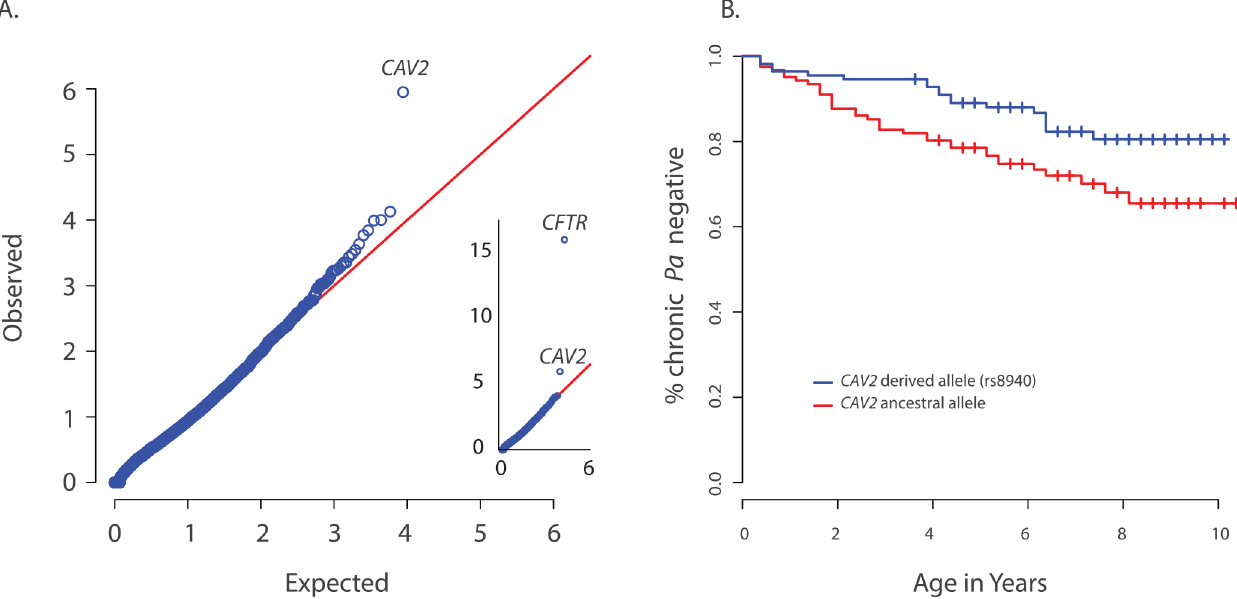
Fig 1. Primary results for CAV2 from exome discovery and validation phases. (A) QQ-plot of p-values from the discovery analysis of exomes from 85 CF individuals with early onset chronic P . aeruginosa infection versus exomes from 3329 non-lung disease European American population controls. P-values are from the SKAT-O test with the small sample adjustment applied to non-synonymous variants grouped by gene to discover genes with differing distributions of these variants between groups. The most significant gene (highest point) is CFTR (p < 1x10 -16 ), followed by CAV2 (p = 1.1x10 -6 ). 1(B) Kaplan Meier curves for age-of-onset of chronic P . aeruginosa infection among individuals in the validation cohort with (blue) and without (red) the CAV2 rs8940 derived allele. Individuals in with at least one rs8940 variant had significantly later age-of-onset (HR = 0.53, p = 0.01, 95% CI = [0.32 – 0.88]).